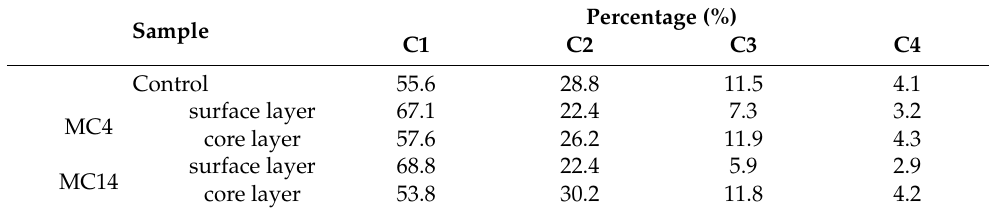
Figure 9. High resolution C1s peaks with subpeaks separated by deconvolution: ( a ) surface layer of sample MC4; ( b ) core layer of sample MC4; ( c ) surface layer of sample MC14; ( d ) core layer of sample MC14; ( e ) the control sample. Table 4. Contribution of C1, C2, C3 and C4 components to the C1s peak from different